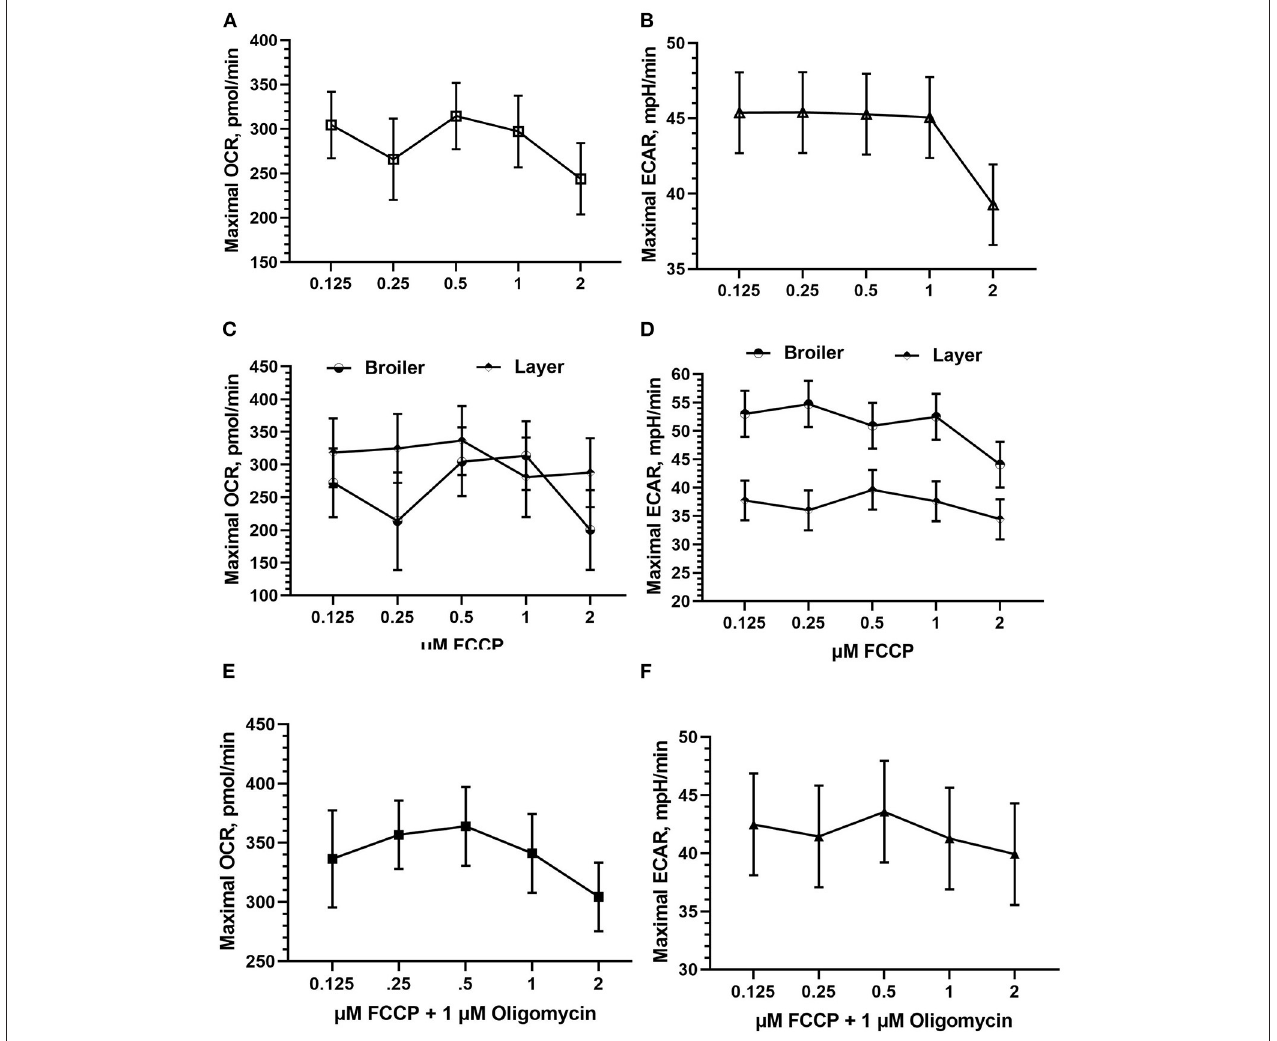
FIGURE 4 | FCCP injection optimization using fresh chicken PBMCs in the Seahorse Xfe24 Analyzer (Agilent) by main effect of FCCP concentration on (A) OCR, (B) ECAR, and the interaction of FCCP concentration x bird line (Ross 308 broiler vs. Bovans layer) on (C) OCR and (D) ECAR. Last, FCCP was titrated in Bovans white layer cells in combination with 1 µ M oligomycin on (E) OCR and (F) ECAR. All data presented are LSMeans